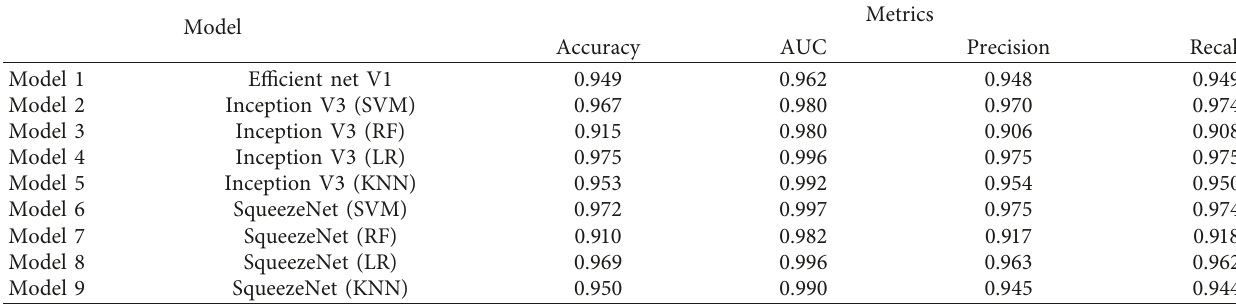
Table 6 indicated that the Inception V3 stacking model